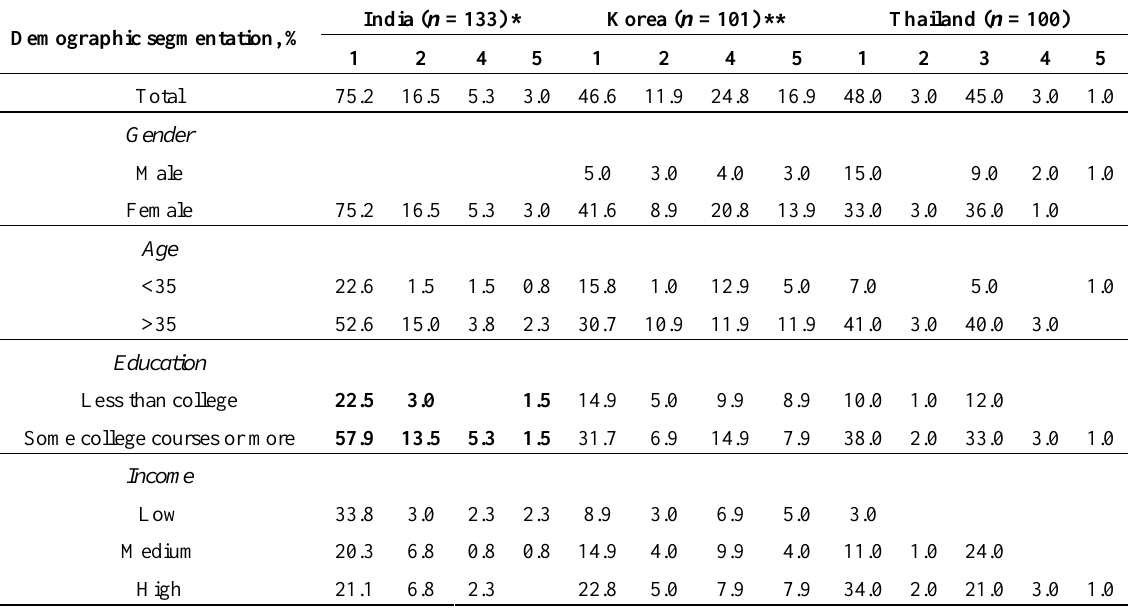
Table 10. Raw poultry and eggs preparation practice. Do you wash raw poultry/eggs before cooking them? Available options included: Yes, I always wash raw poultry (1); Yes, I always wash eggs (2); Yes, I always wash poultry and eggs (3); Sometimes—if they seem dirty (4); No